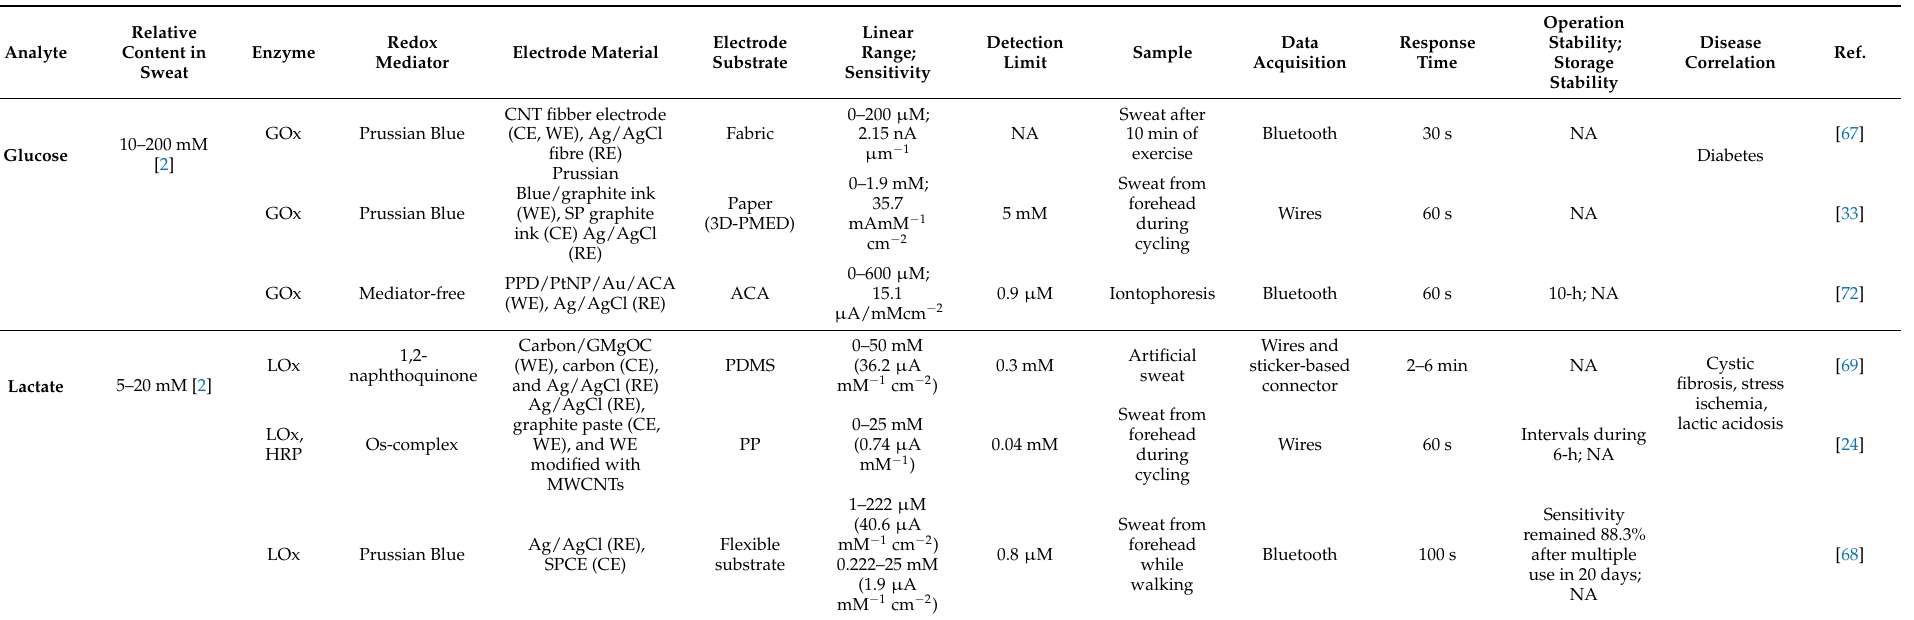
Table 4. Enzyme electrode biosensors for sweat analysis. References: ACA: anisotropic conductive adhesive; AOx: alcohol oxidase; HRP: horseradish peroxidase; LOx: lactate oxidase; MWCNTs: carboxy-functionalized multiwalled carbon nanotubes; PB: Prussian blue; PDMS: polydimethylsiloxane; PP: polypropylene; PPD: poly-m-phenylenediamine; SPCE: screen-printed carbon electrodes; SPPB: screen-printed Prussian blue conductive carbon; 3D-PMED: 3D paper-based microfluidic electrochemical integrated device; NA: not